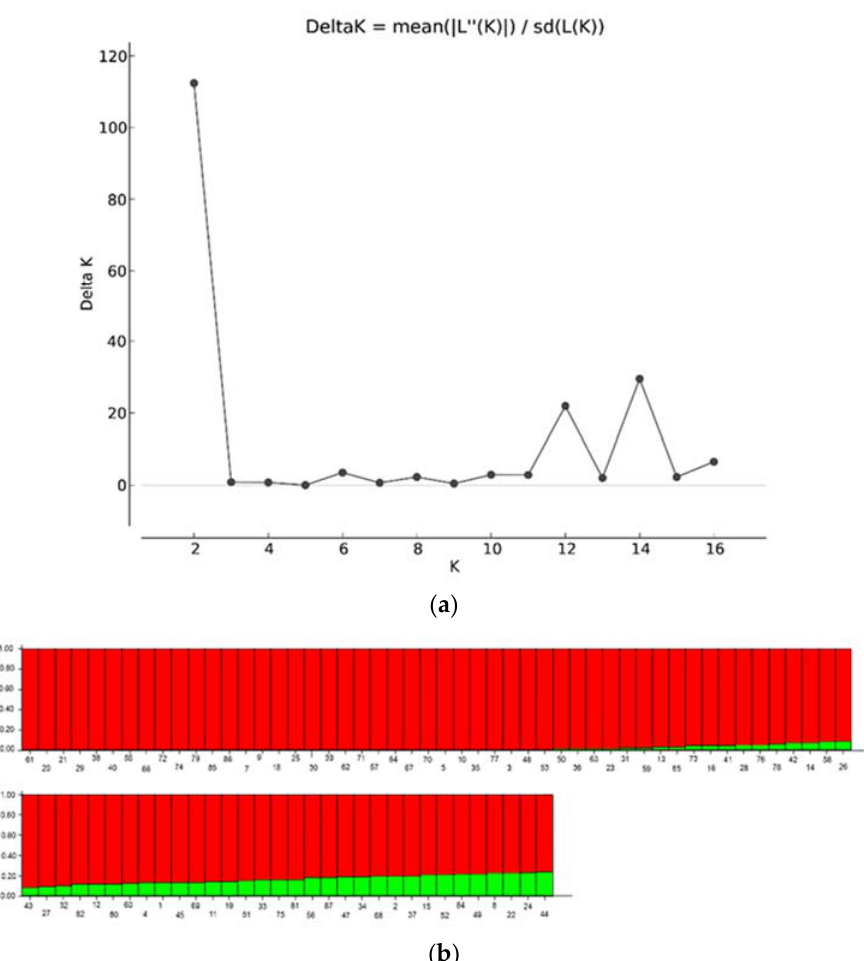
Figure 4. ( a ). Results from the STRUCTURE Harvester analysis, revealing the most likely value of K based on STRUCTURE results; ( b ). determination of the optimal value of K and population structure of CPB genotypes using DArTseq SNP markers.